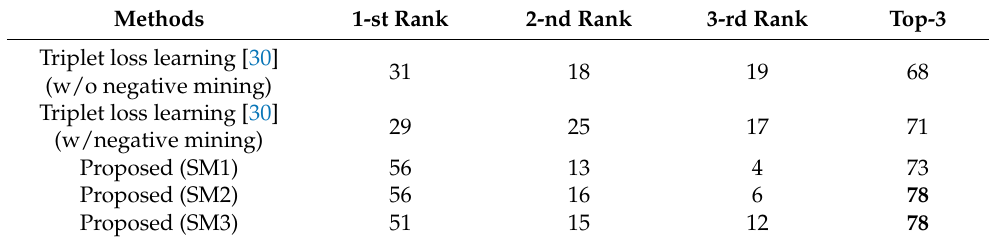
Table 4. Comparison of CAD retrieval performance with triplet loss network [30]. (100 untrained RGB images are